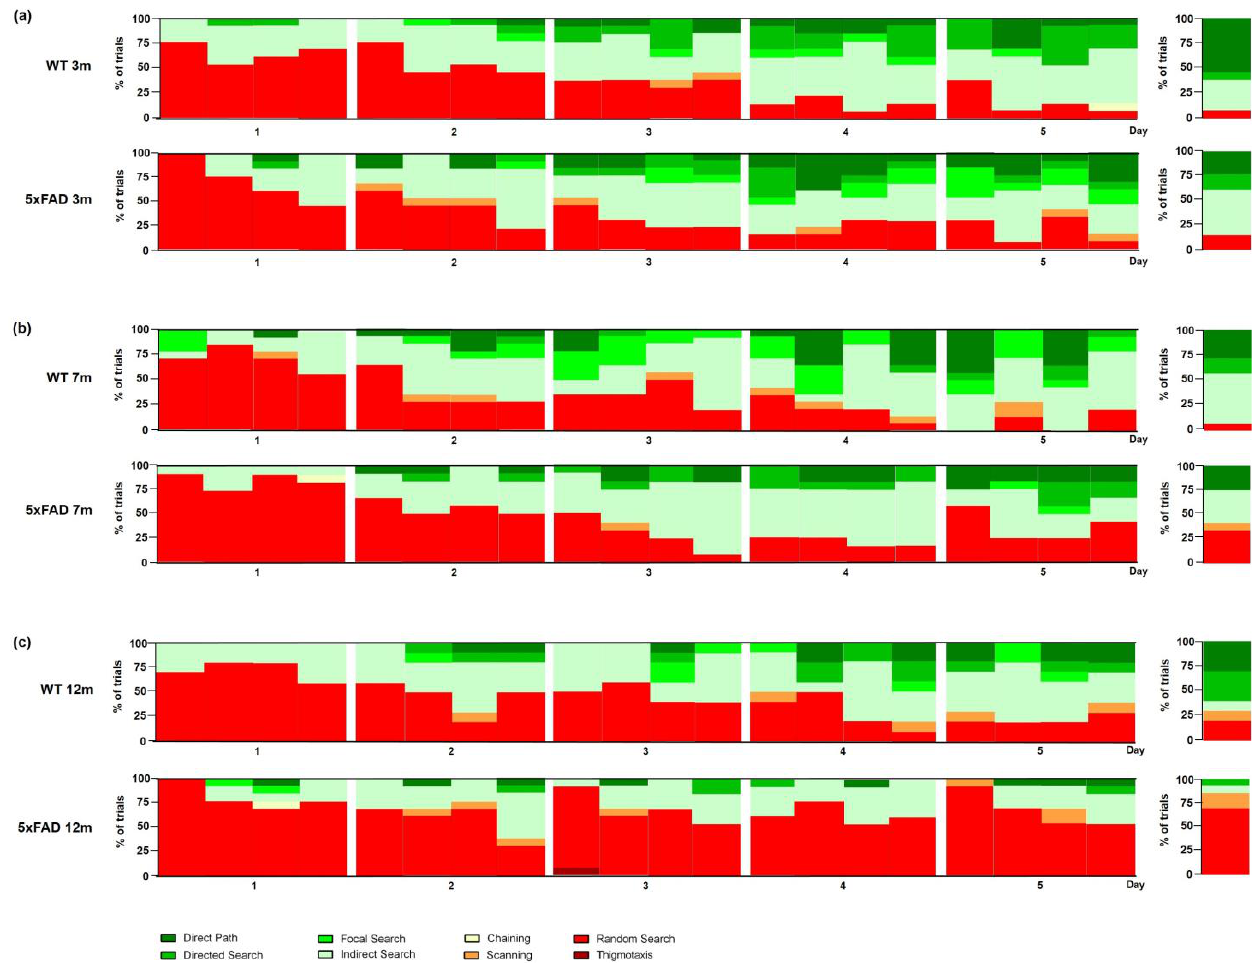
Figure 8. Qualitative analysis of spatial learning in male 5xFAD mice. Search strategies used by male 3 m- ( a ), 7 m- ( b ), and 12 m- ( c ) old 5xFAD and same-aged WT mice. Data represent the percentage of search strategies performed in each trial over the 5 days of acquisition training and during the probe trial. n = 10 – 13.